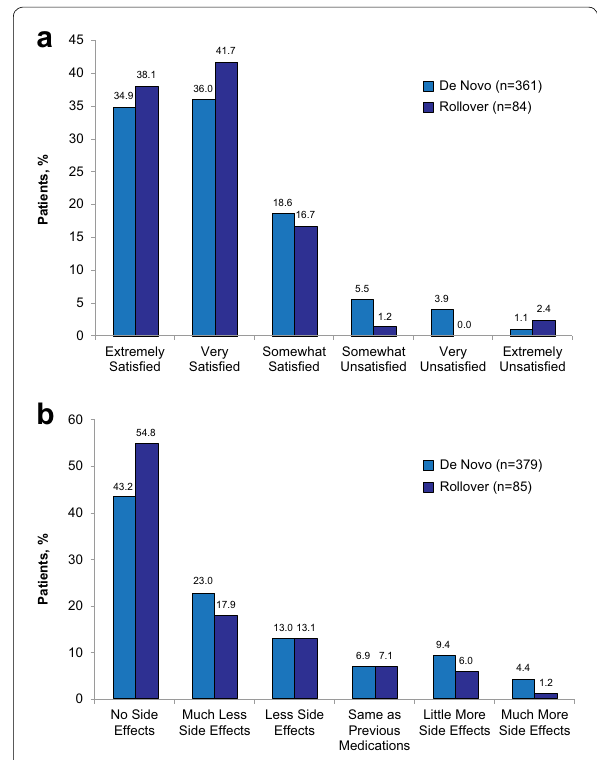
Fig. 4 Patient evaluation of own satisfaction with AOM 400 ( a ) and patient assessment of side effects on AOM 400 relative to previ- ous medication ( b ) using the Patient Satisfaction with Medication Questionnaire-Modified; data collected at last visit of the AOM 400 maintenance phase. AOM 400 aripiprazole once-monthly 400